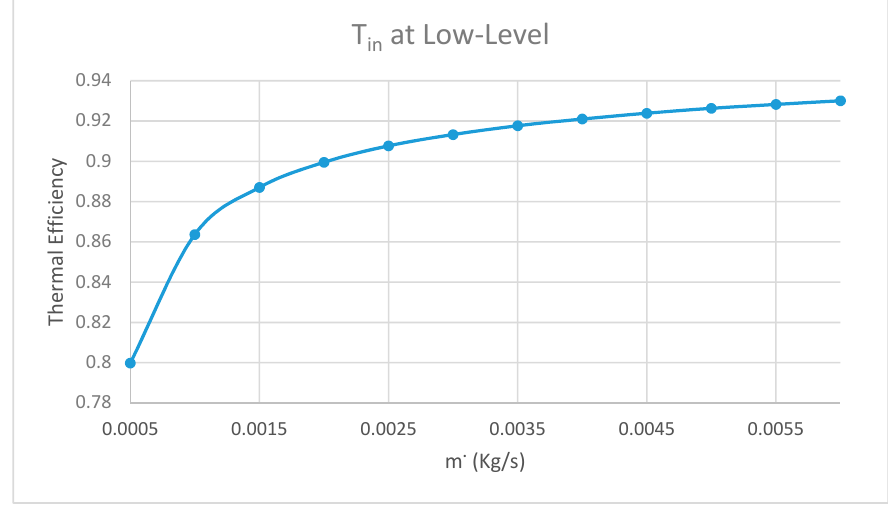
Figure 10. The effect of inlet flowrate on (cid:2015) (cid:3047)(cid:3035) at Low-Level inlet temperature.